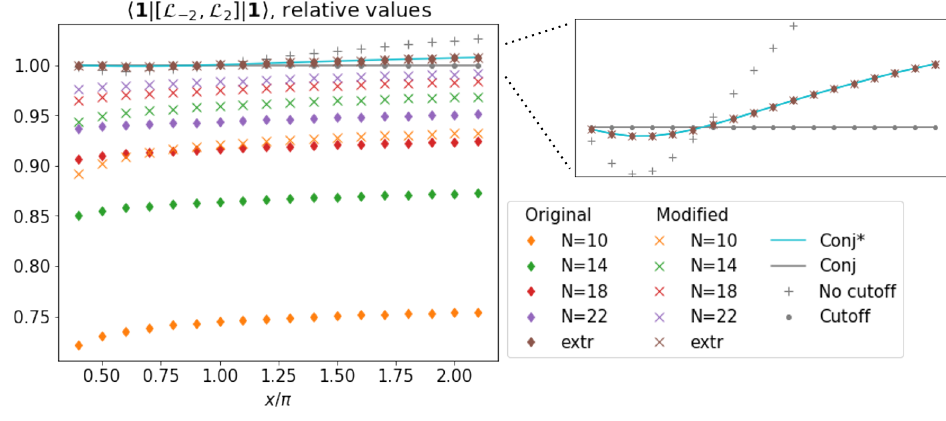
Figure 7 . Remake of (cid:12)gure 2. In this remake the commutator [ L (cid:0) 2 ; L 2 ] is used, rather than the product L (cid:0) 2 L 2 , and no cuto(cid:11) is taken. This commutator is denoted \Original". We also show the result using a modi(cid:12)ed version of the Koo-Saleur generators given by (7.25), labelled \Modi(cid:12)ed". \Conj*" refers to the result found by applying (7.24), while \Conj" refers to the CFT result as in (cid:12)gure 2. The same sizes N and method of extrapolation is used as in (cid:12)gure 2, and the extrapolated values from (cid:12)gure 2 are shown for comparison (\No cuto(cid:11)" and \Cuto(cid:11)"). proportional to c inside the parenthesis cancel out for any values of m; n; p , while those proportional to c (cid:3) cancel because of the constraint p = (cid:0) m (cid:0) n . We could indeed